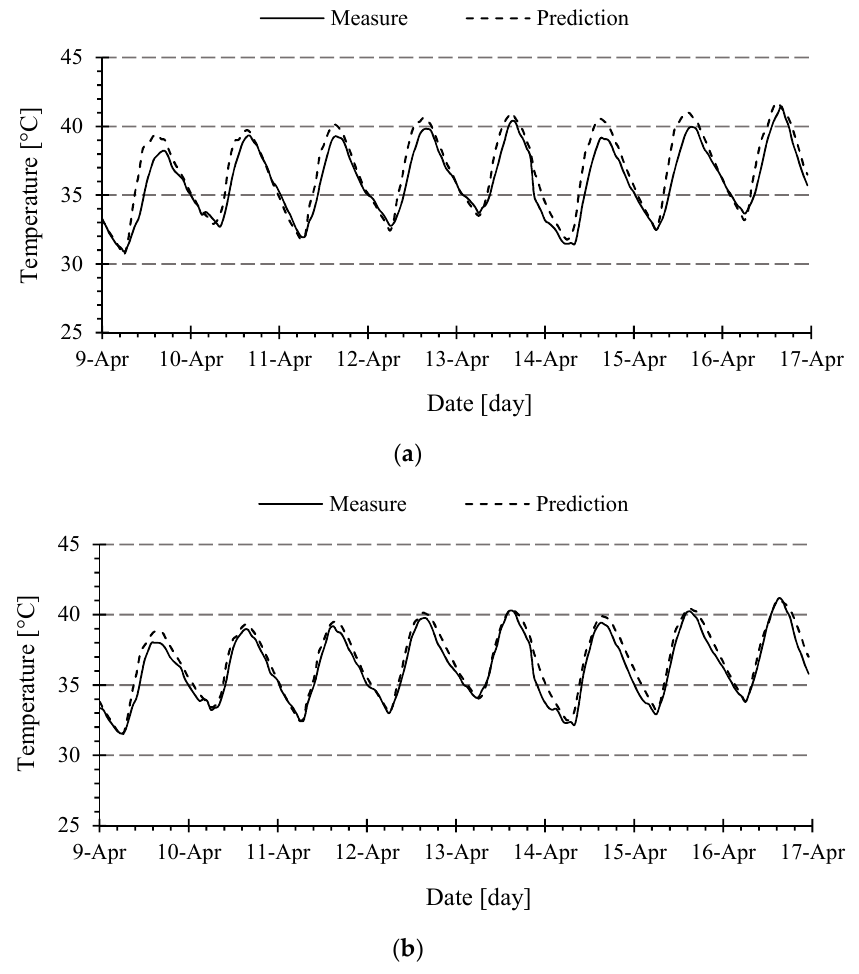
Figure 7. Evolution of measured and predicted temperatures in the ( a ) living room and ( b ) bedroom.